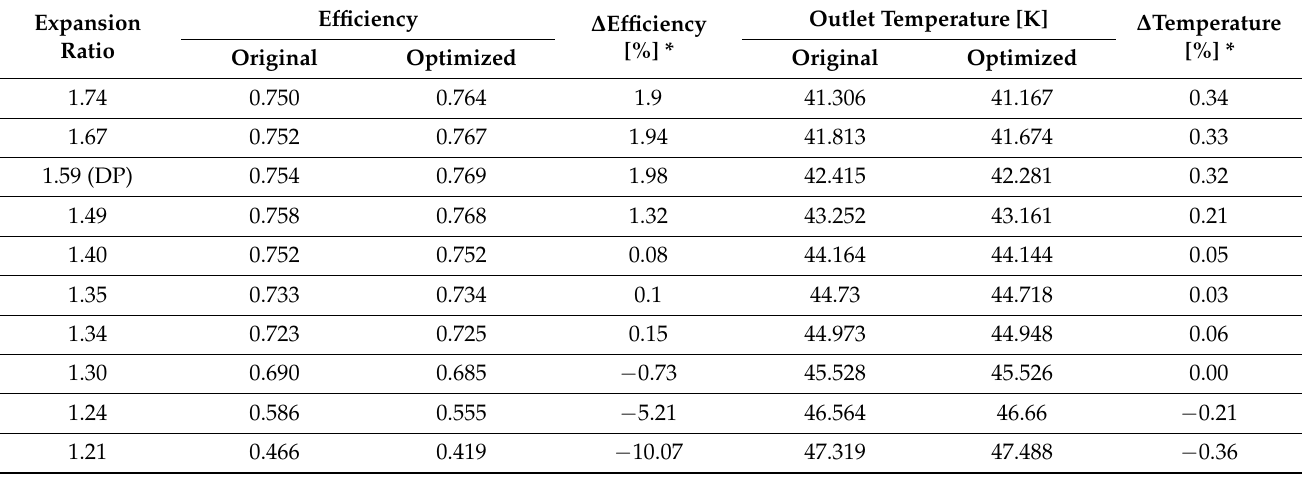
Table 6. Efficiency and outlet temperature comparisons between original and optimized